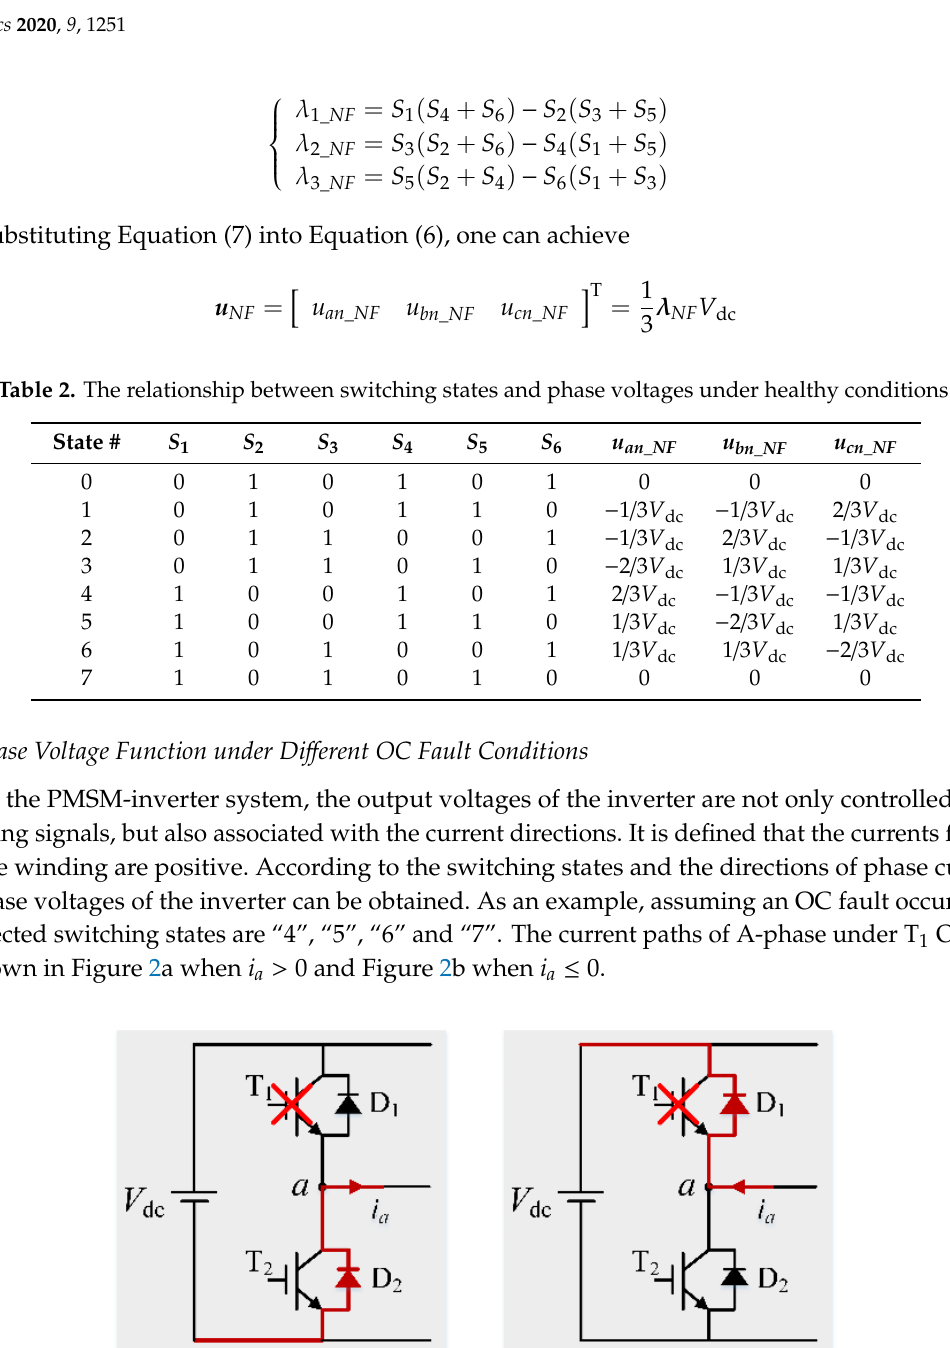
Figure 2. The current paths of A-phase under a T1 open-circuit (OC) fault: ( a ) i a